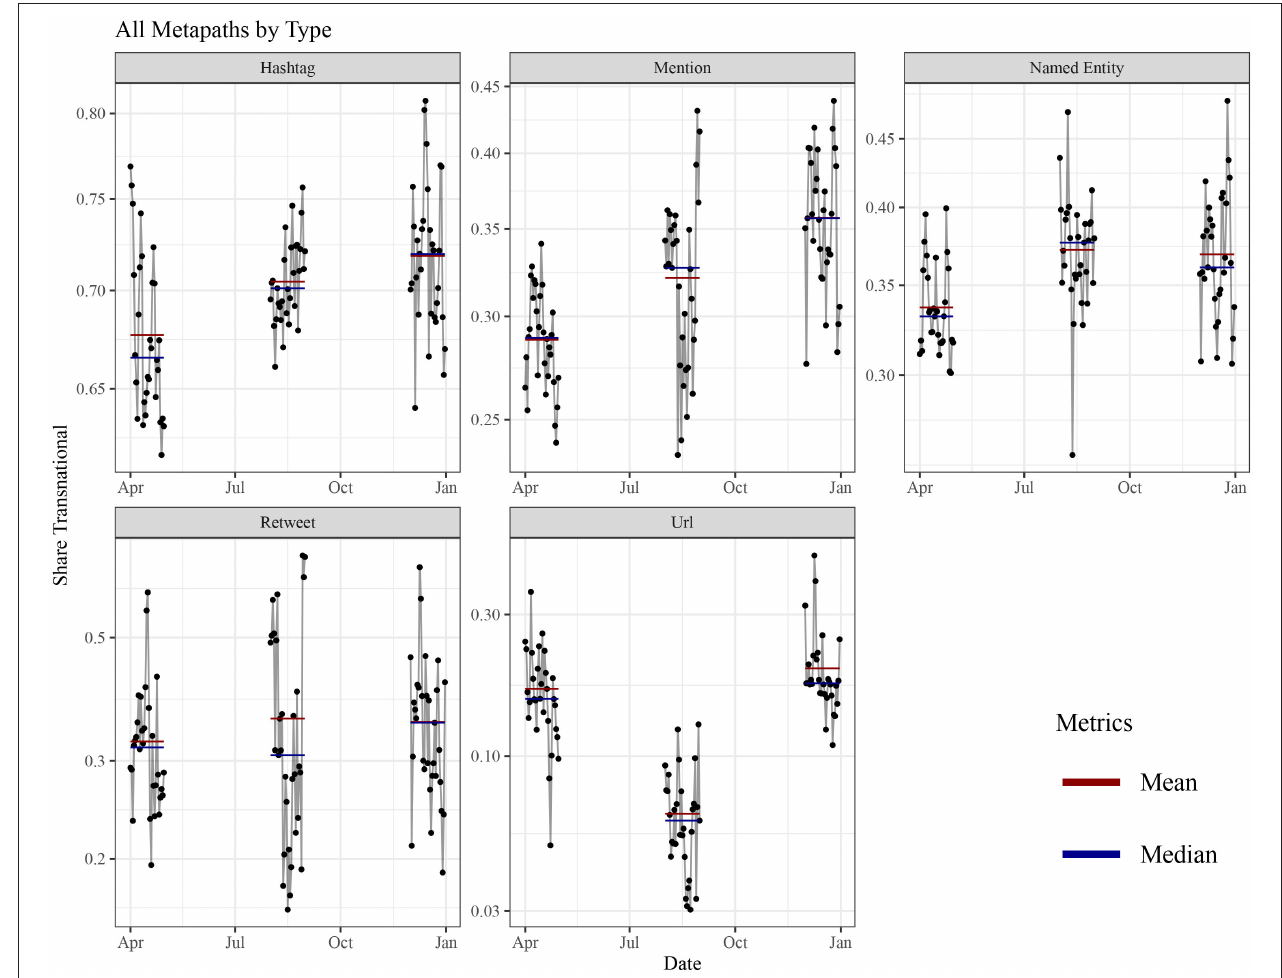
FIGURE 3 | Share of transnational linkages for all meta paths. The subfigures show the development of the share on a daily base (black line), monthly mean (red line) and monthly median (blue line), differentiated by type of path. The shares are presented on a logarithmic scale (y- axis) to better account for different magnitudes.